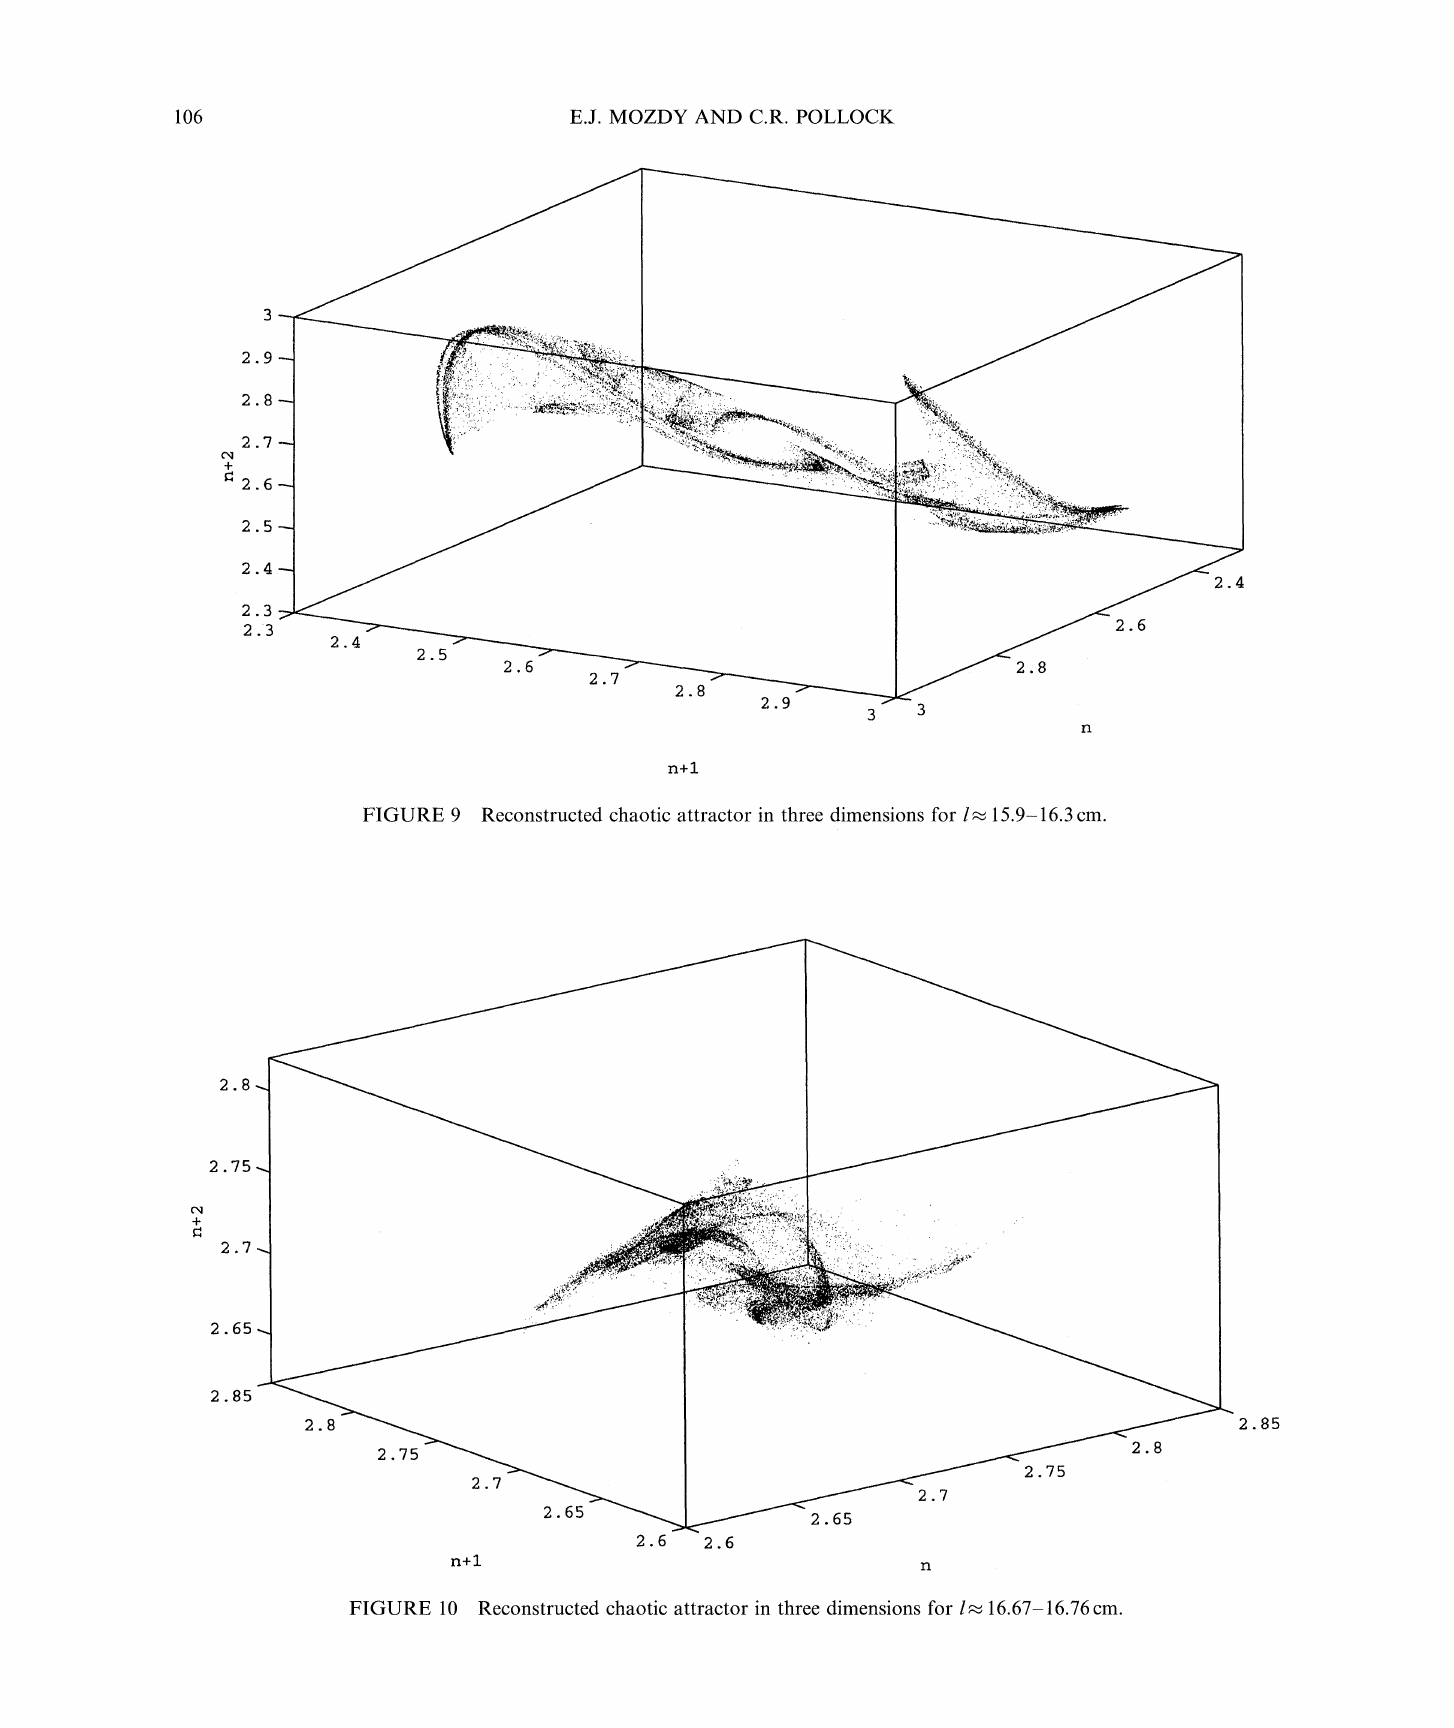
FIGURE 10 Reconstructed chaotic attractor in three dimensions for l